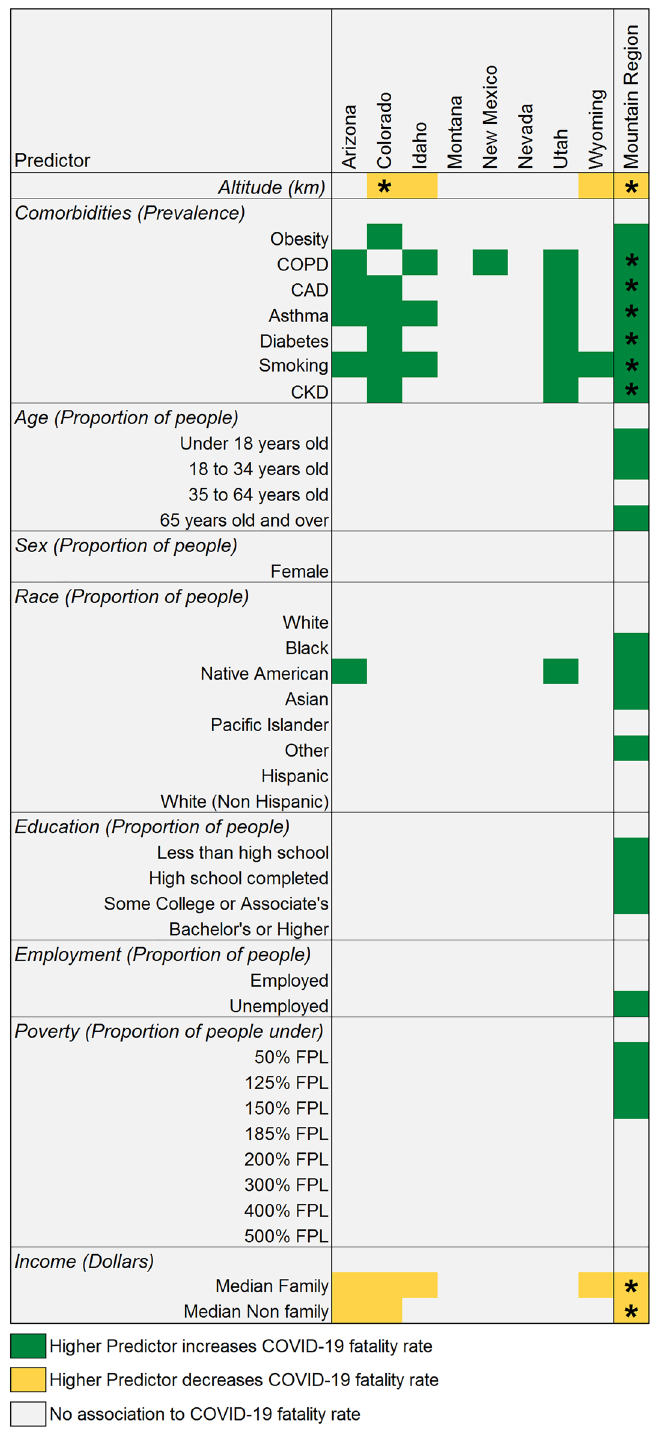
Figure 2. COVID-19 fatality rate association to county-wide comorbidities and demographic factors adjusted by population density. Only those associations that were detected as significant (P ≤ 0.05) are shown. Asterisk (*) indicates significance of a specific predictor at a Bonferroni threshold (37 tests). Mountain region corresponds to all states evaluated as a